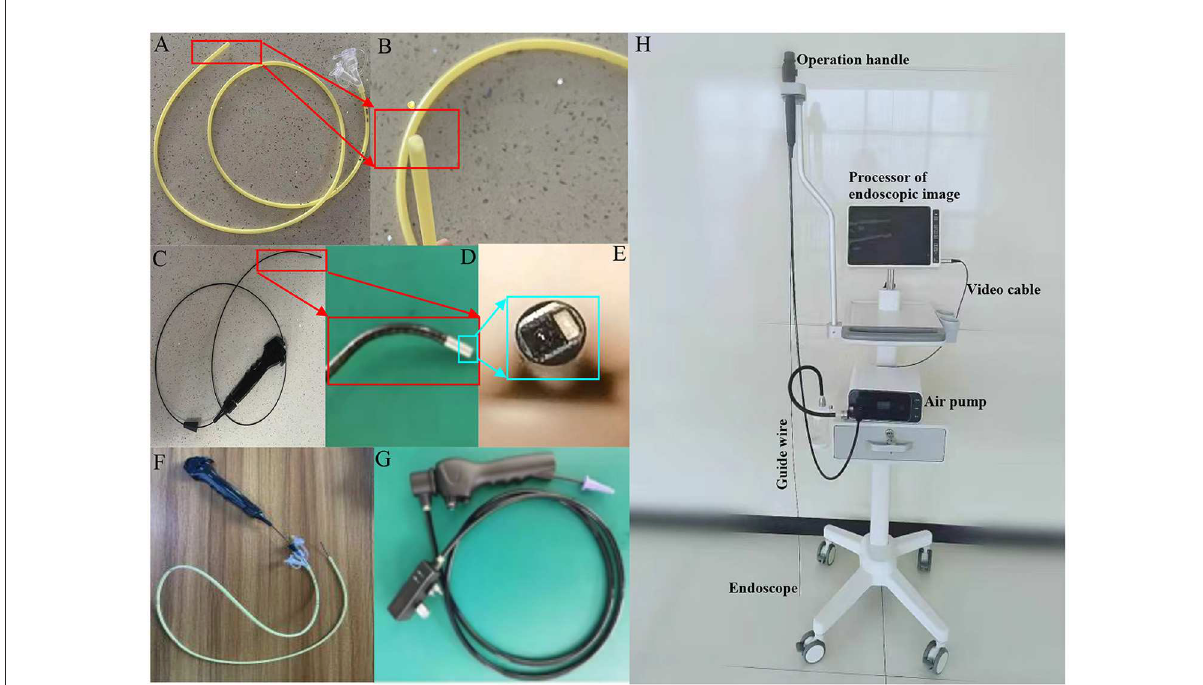
FIGURE1 The system for endoscopic placement of nasojejunal feeding tubes. (A) A nasojejunal feeding tube. (B) The bullet shaped tip of the feeding tube. (C) Operable handle, guide wire, and endoscope connected with another end of the wire. (D) The end of guide wire and endoscope. (E) The tip structure of an endoscope. (F) The assembly is composed of an operable handle, guide wire, an endoscope, and a nasojejunal feeding tube. (G) Power cord and an operation handle. (H) The instrument of for endoscopic placement of feeding